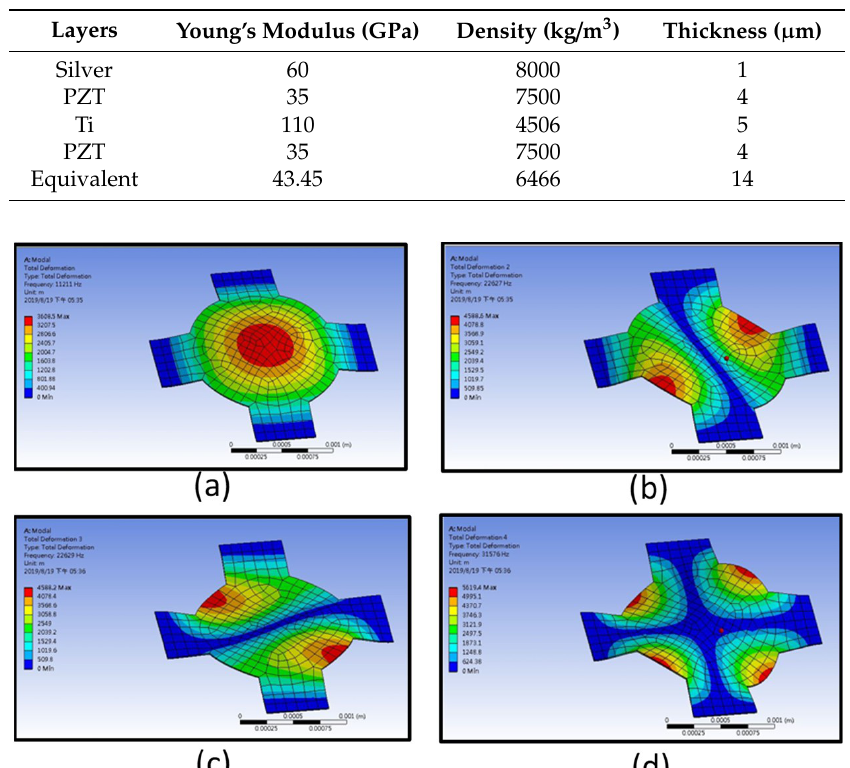
Table 1. Parameters used in the ANSYS simulation.